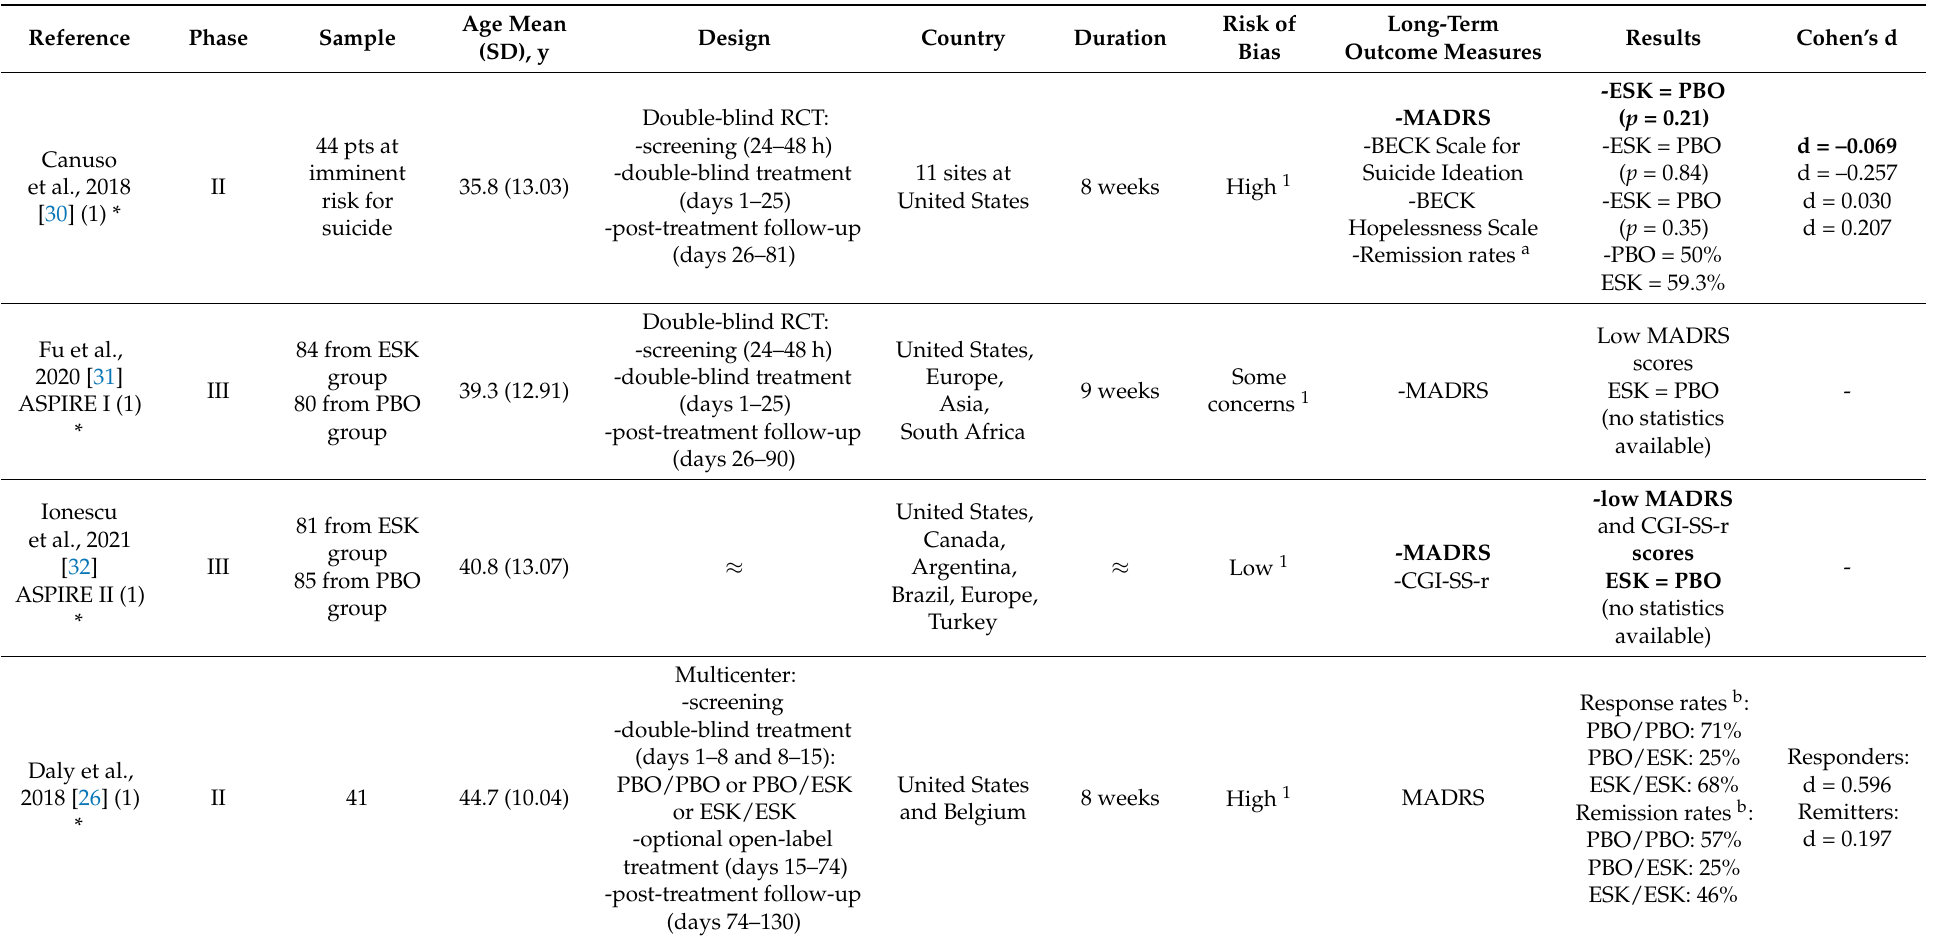
Table 2. Summary of the studies on intranasal ESK efficacy in the follow-up phase (TAU) after the 4-week induction